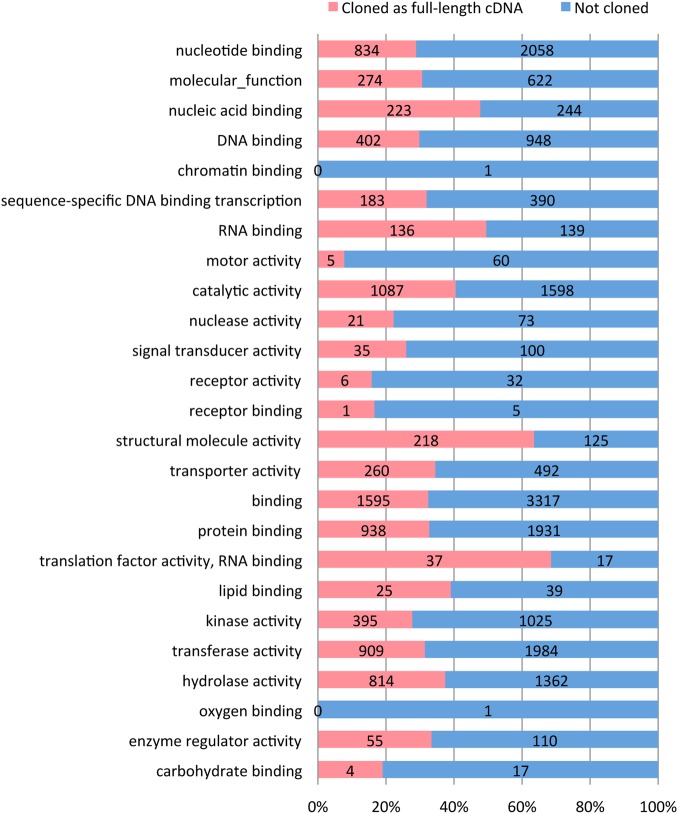
Ratio of sorghum genes cloned as full-length cDNAs in a functional classification based on GO slim categories of available genes annotated in sorghum genome (Sbicolor_255). The represented data is for the category of molecular function. The labels show the number of genes.